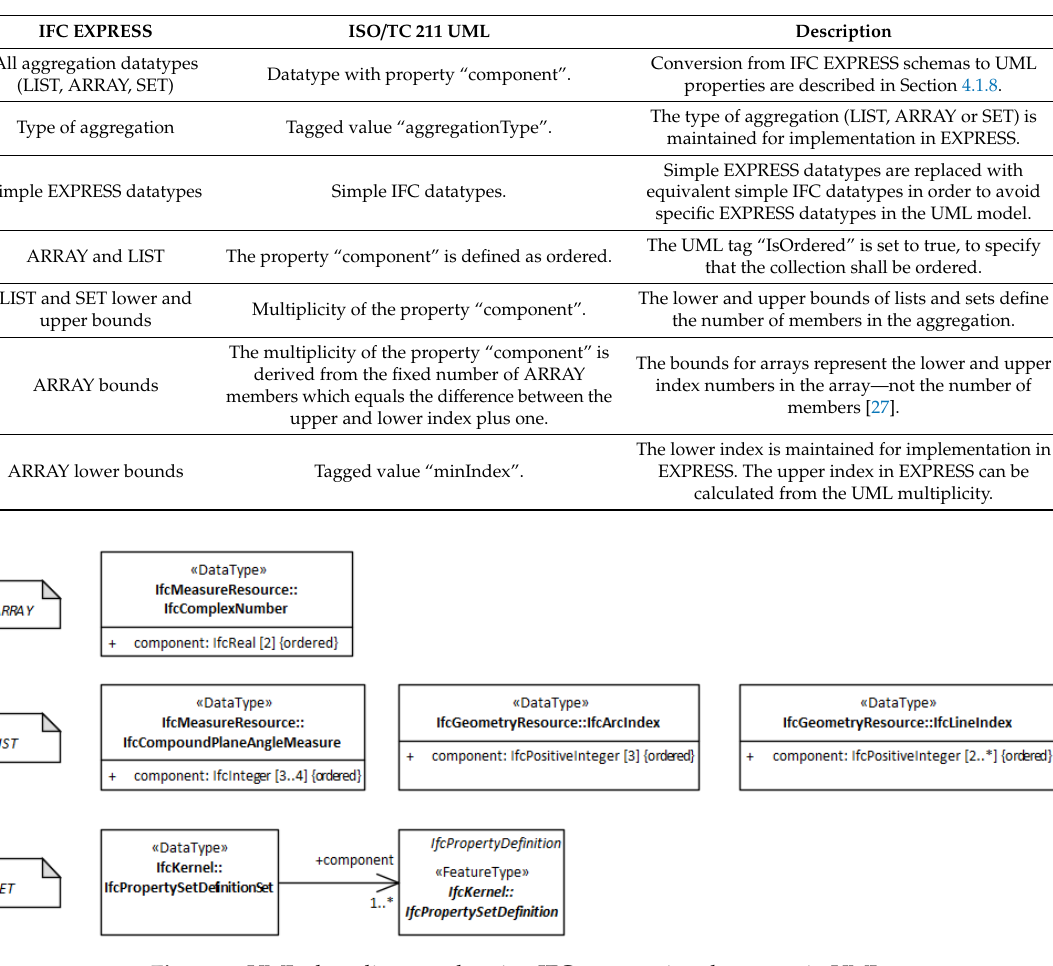
Table 6. Conversion pattern for aggregation datatypes.